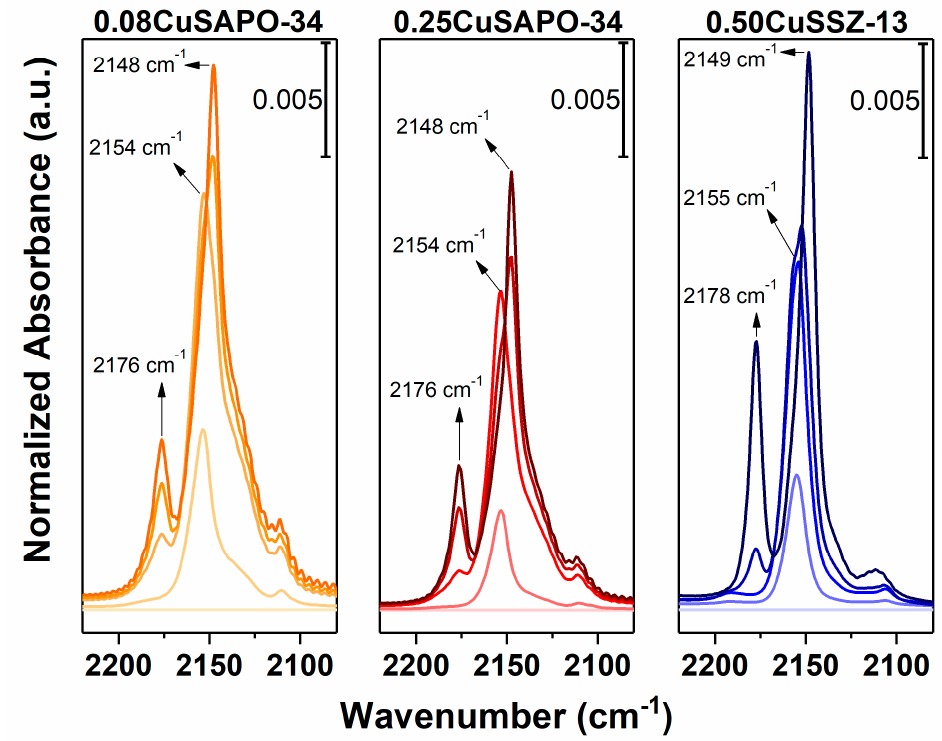
Figure 5. FT-IR spectra of adsorbed CO at RT on 0.08CuSAPO-34 (orange), 0.25CuSAPO-34 (red) and 0.50CuSSZ-13 (blue). The CO pressure was increased from 20 μ bar to 20 mbar. The materials were activated for 1 h at 150 °C, 300 °C and 450 °C. The spectra are background subtracted and normalized to the framework overtones as well as to the Cu content ( μ mol/g).